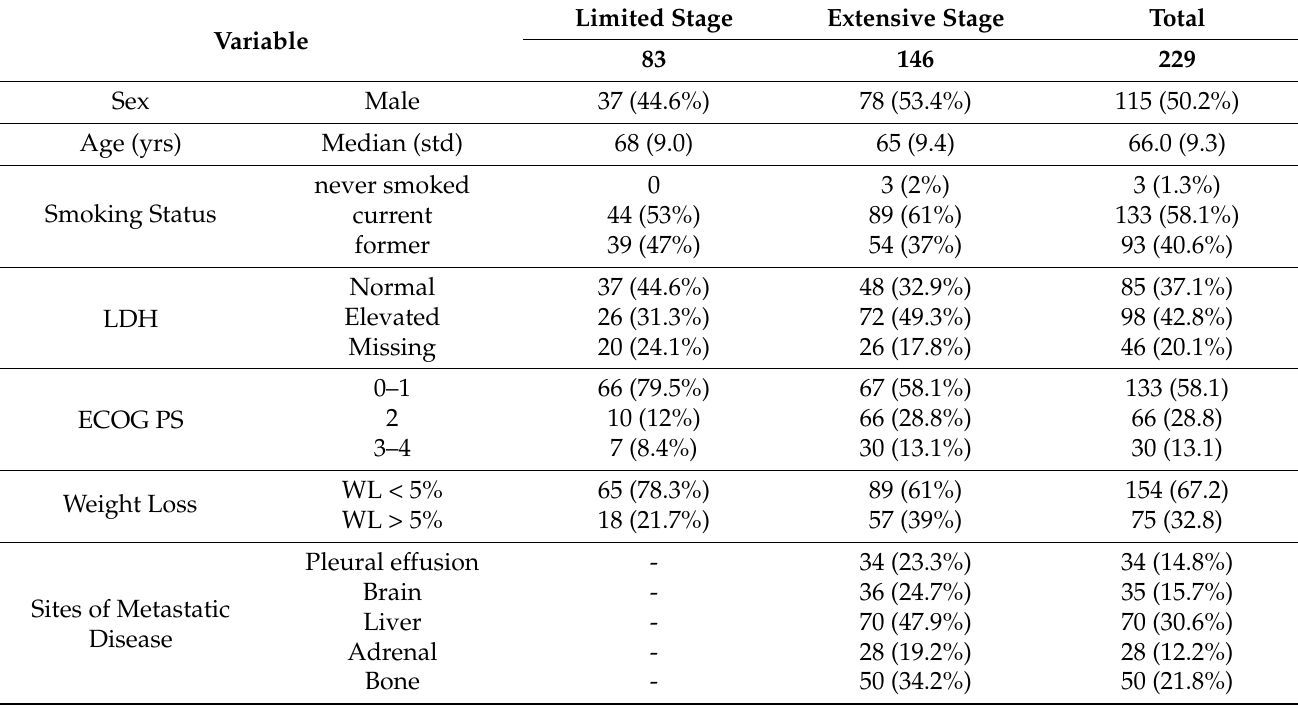
Table 1. Patient